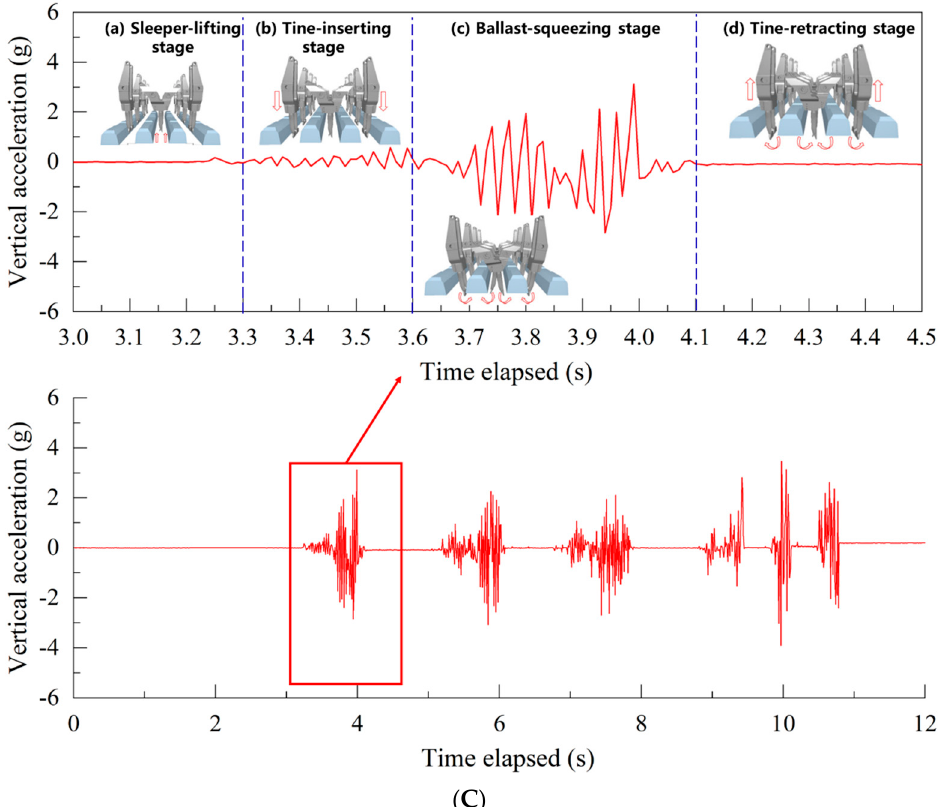
Figure 12. The time-history curves of ( A ) lateral, ( B ) longitudinal, and ( C ) vertical acceleration responses recorded by #R1 during tamping operation.